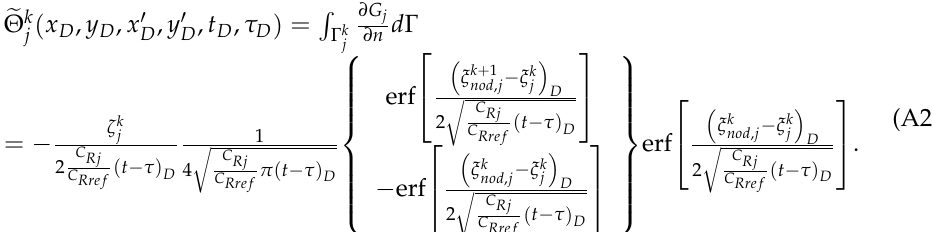
Figure A4. Local coordinate system defined for k -th element on Г 𝒋 .